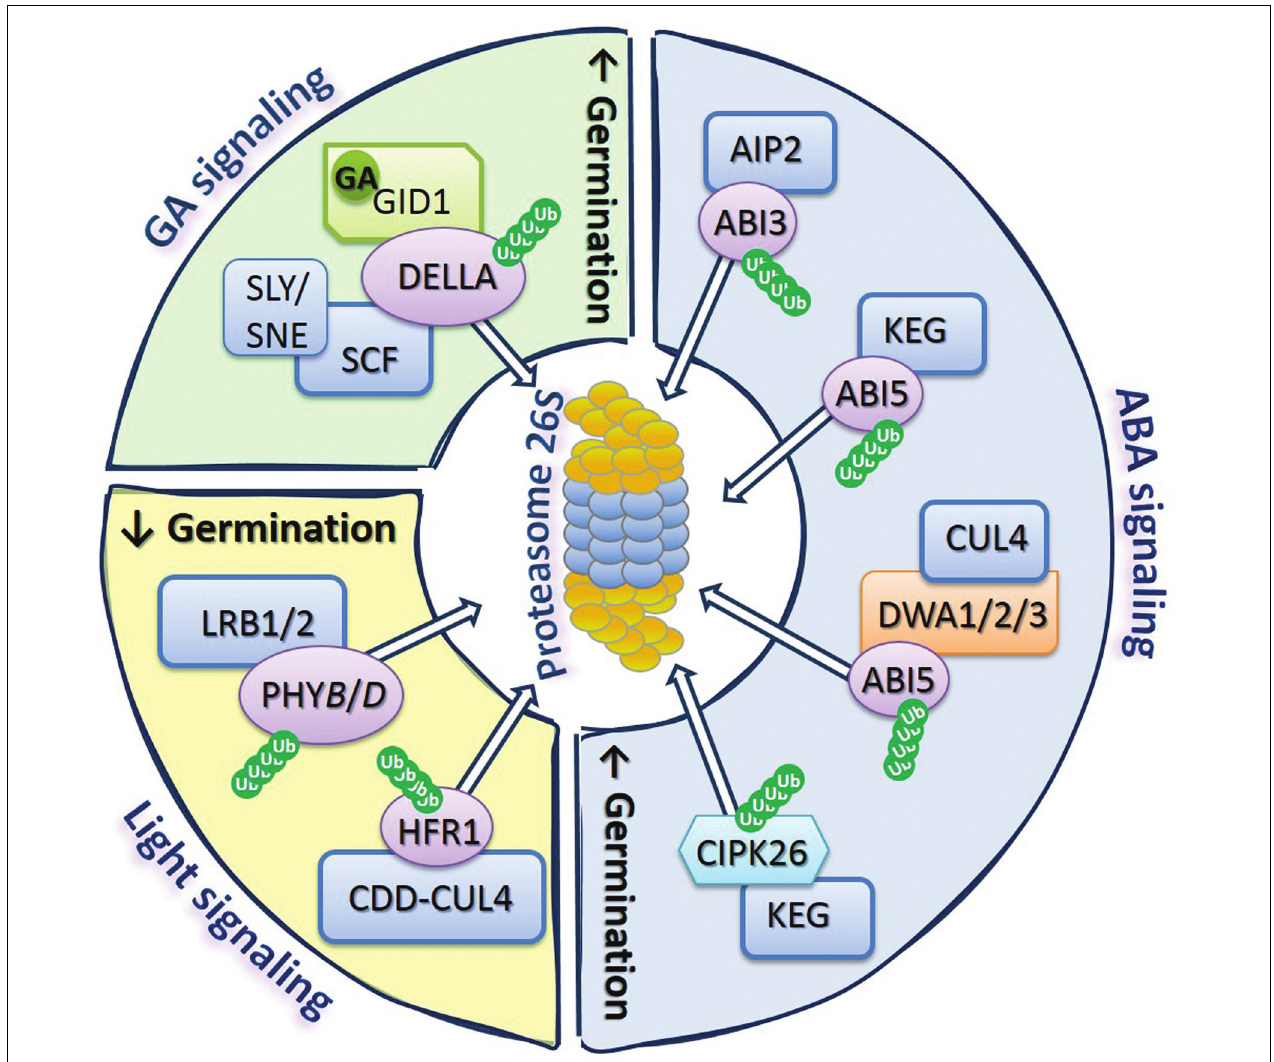
FIGURE 2 | The 26S proteasome as a regulatory hub of GA, ABA, and light signaling. The complex of proteases called as the proteasome 26S together with various types of E3 ligases ubiquitinating target proteins are key components of the mechanism controlling accumulation of regulatory proteins involved in GA, ABA, and light signaling pathways, determining the germination potential of the seed. Proteasome modulate GA signaling by degradation of DELLA proteins, which in the presence of GA can bind to GID1 receptors and SCF complex resulting in DELLA ubiquitination, allowing recognition of targeted proteins by the 26S complex. ABA signaling is controlled by the degradation of ABI3 and ABI5 transcription factors, as well as CIPK26 regulatory proteins, by 26S proteasome after ubiquitination of these proteins by different types of E3 ligases, such as AIP2, KEG, and CUL4. Light signal perception by germinating seeds rely mostly on the modulation of abundance of PHY B , which depends on the activity of CDD-CUL4 ligase complex, as well as LRB1/2 regulatory proteins allowing ubiquitination of PHY B and degradation by 26S proteasome. Degradation of regulatory proteins involved in GA and ABA signaling leads to stimulation of germination, while degradation of regulators of light signaling affects germination (indicated by up- or down-oriented arrows). Ub,